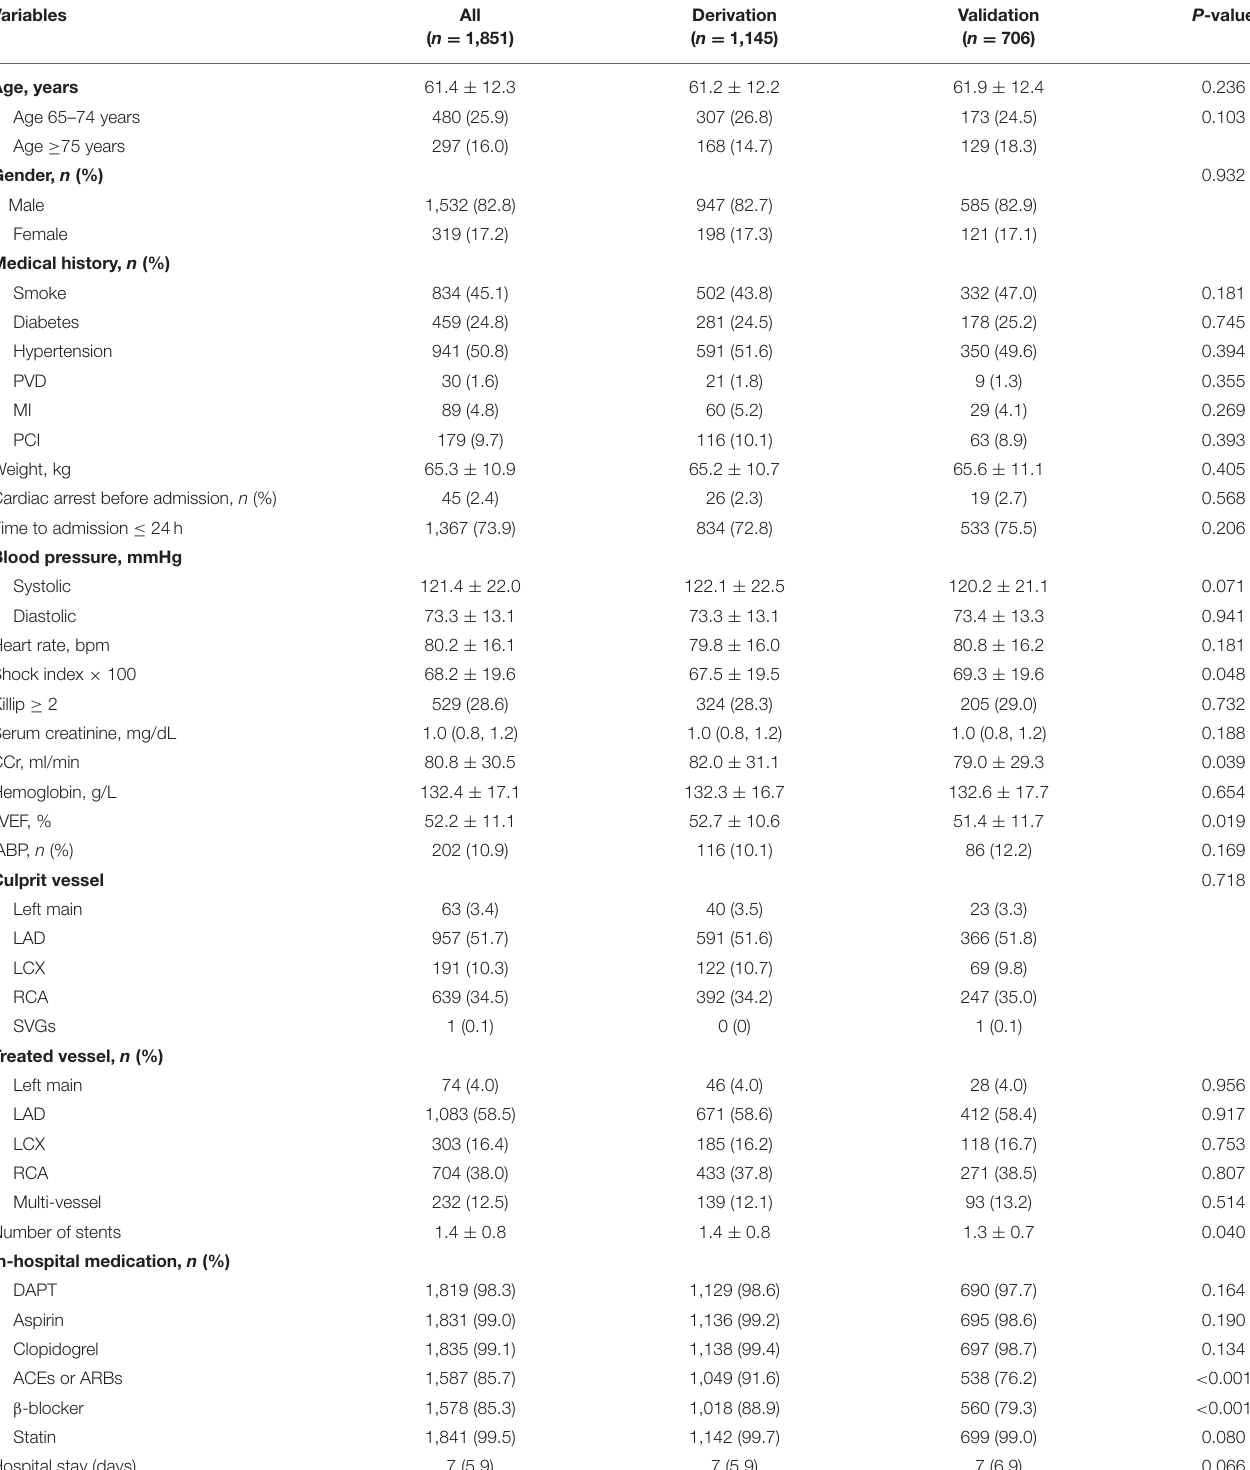
TABLE 1 | Baseline characteristics of patients in the model derivation and validation